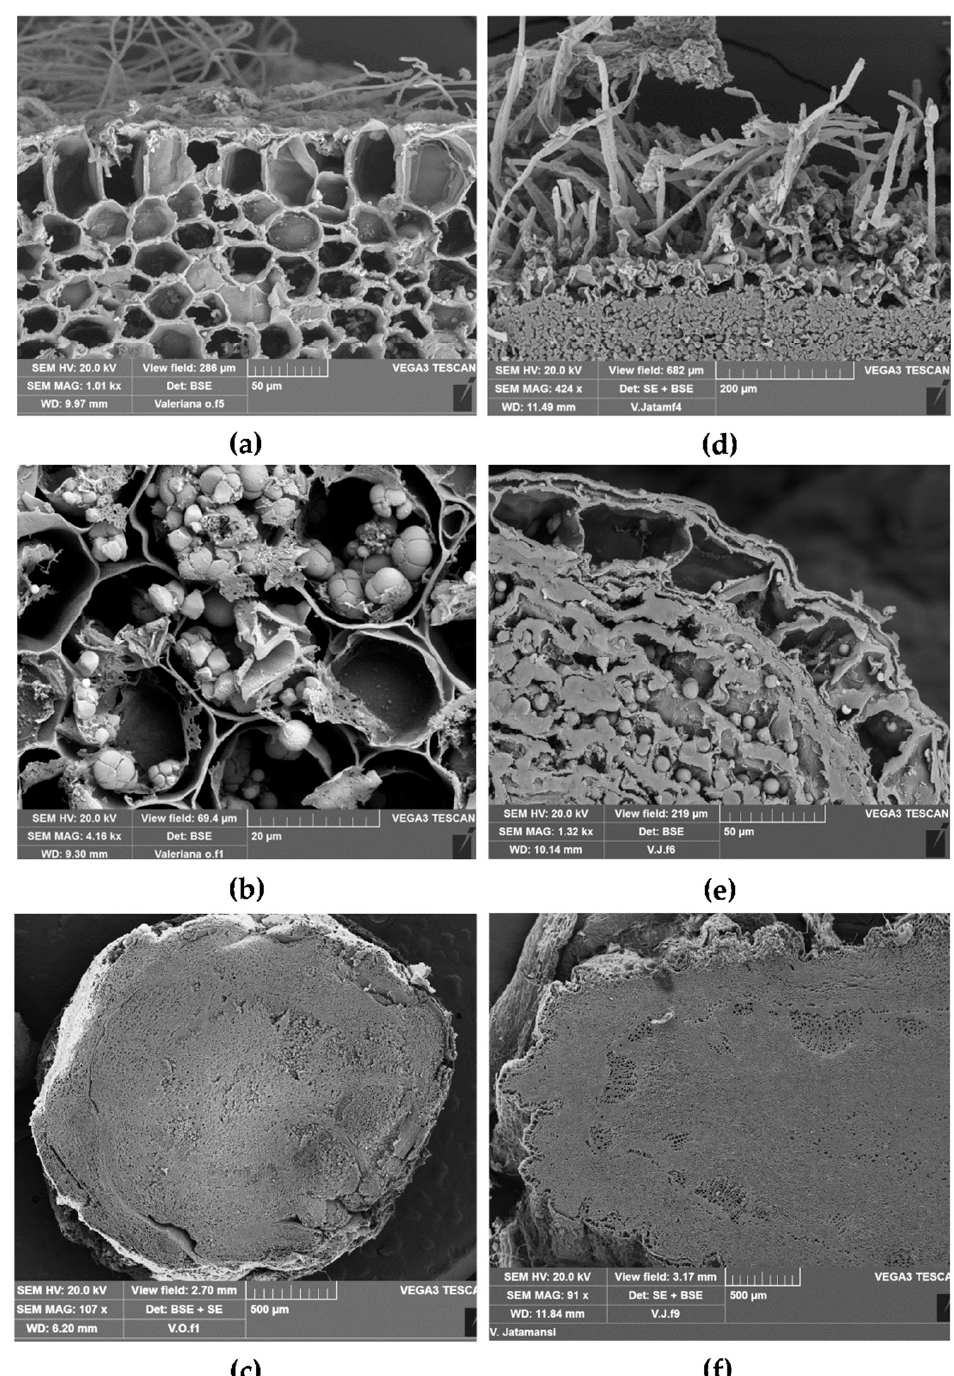
Figure 3. Scanning electron microscopic view of TS of root / rhizome from Vo ( a – c ) and Vj ( d – f ): ( a ) epidermis with root hairs and the hypodermal layer of the cortex; ( b ) starch occurring as single or compound grains (2–6 components) within cortical parenchymatous cells; ( c ) TS of rhizome showing vascular bundles circularly arranged; ( d ) epidermis with many root hairs and parenchymatous cells filled with starch grains; ( e ) exoderm and parenchymatous cells filled with starch, generally occurring as single or compound grains with two components; ( f ) TS of rhizome with many vascular bundles surrounding the central pith.